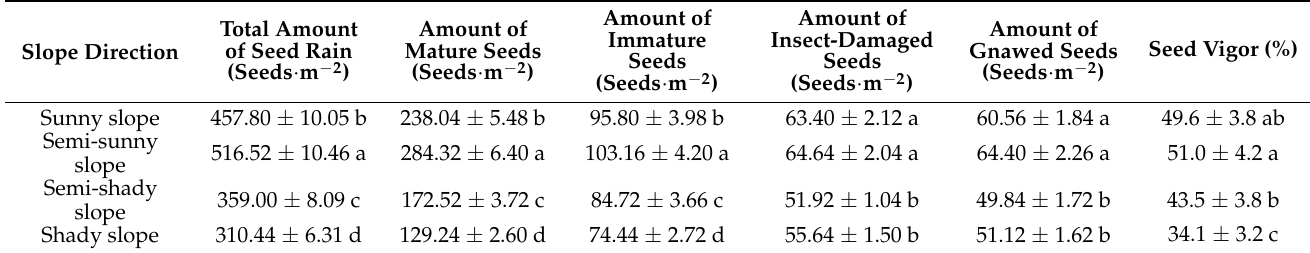
Table 3. Cumulative characteristics of Castanopsis hystrix seed rain on different slope